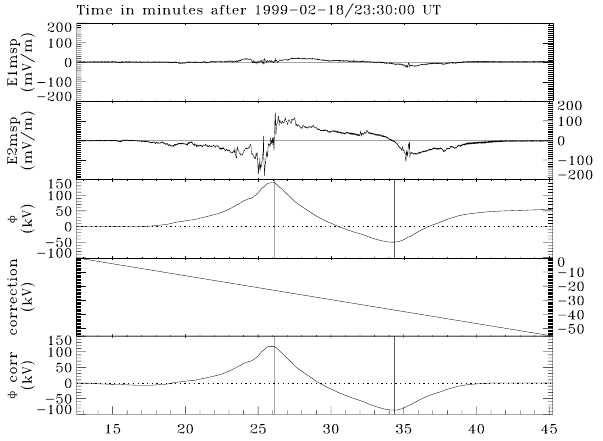
Fig. 1. First three panels show the two measured components of the electric field in the spin plane and the calculated potential along this dawn-to-dusk orbit above 40 ◦ corrected geomagnetic latitude. The last two panels show the potential correction assuming a return to zero potential at low latitudes and the resulting corrected potential. The corotation electric field has been